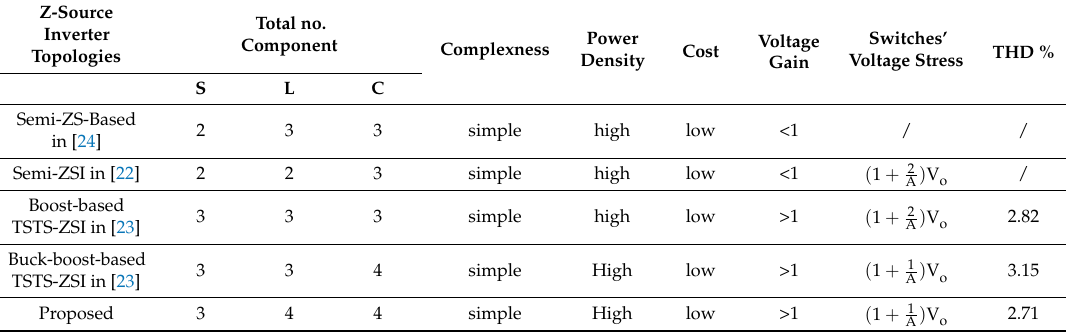
Table 2. Comparative summary of the proposed inverter with other Z-source inverters.